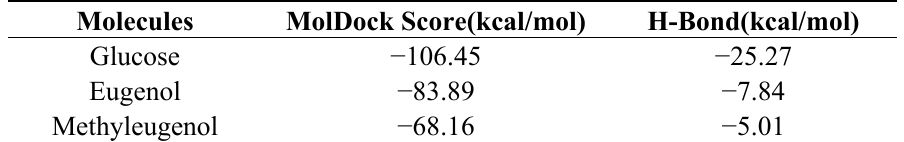
Table 3. Energy calculations by MVD/MolDock Score and H-bond docking